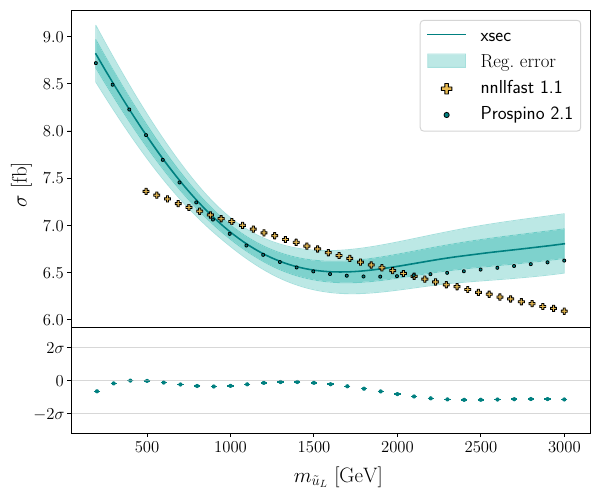
Fig. 5 Gluino pair-production cross-section as a function of the ˜ u L mass. All other squark masses are fixed at 1TeV and the gluino mass is set to 1.5TeV. Shown is the central xsec prediction (solid line), the 1 σ and 2 σ regression error bands (shaded regions), the Prospino values (dots) and the corresponding NNLL-fast NLO result (crosses)